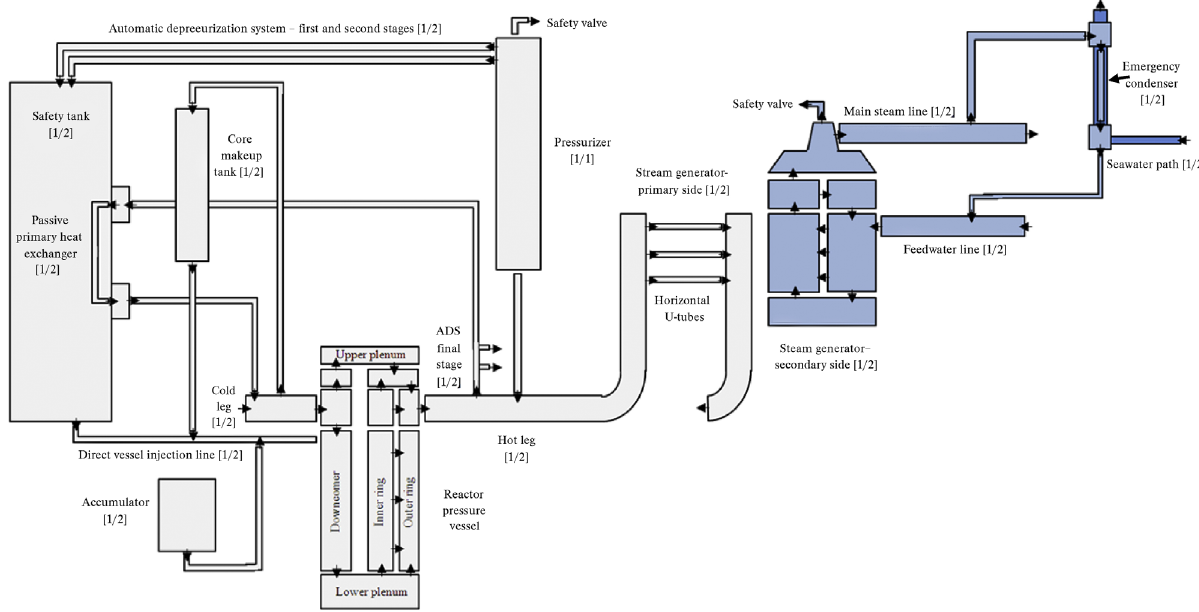
Fig. 6. ATHLET model. Dimensions are not representative. The model includes about 200 objects composed of about 1000 control